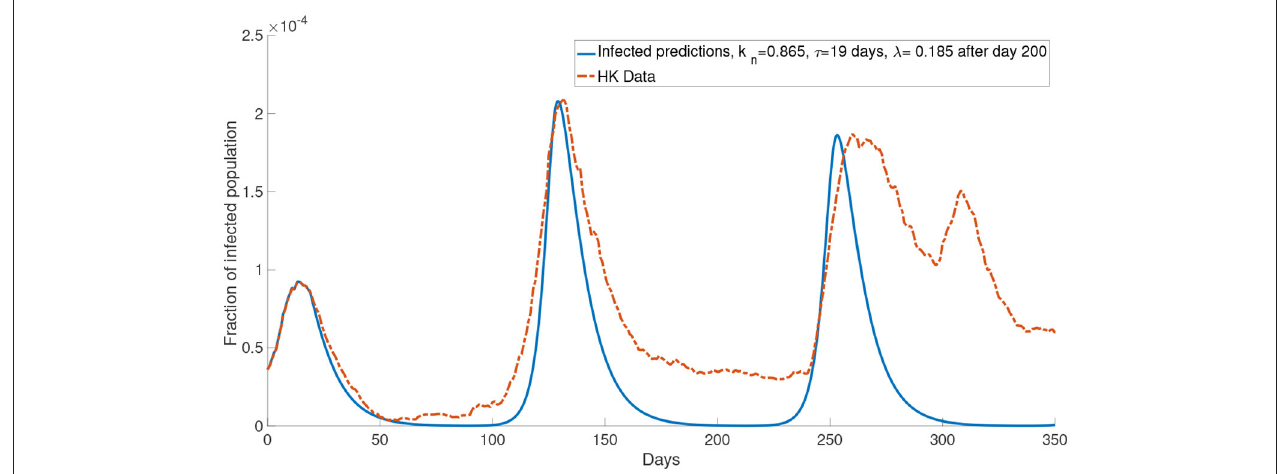
FIGURE 12 | The comparison of the data and the simulation for the system with M = 3 with λ increased to 0.185 after day